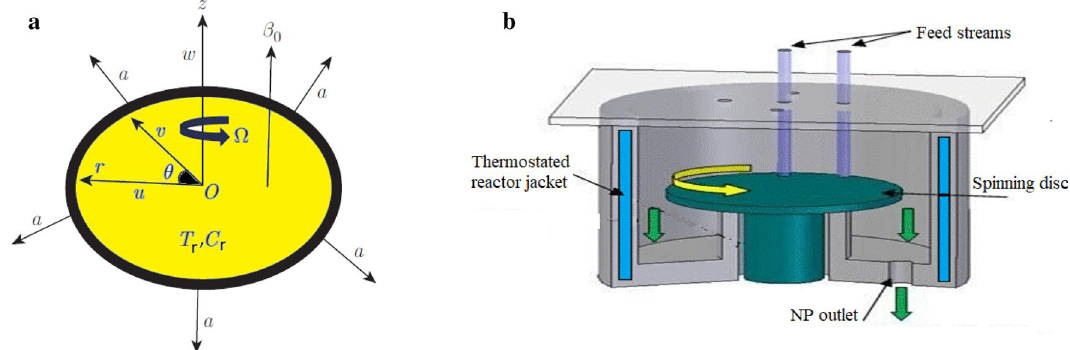
Figure 1. ( a ) Physical flow configuration. ( b ) A design of the spinning disc reactor